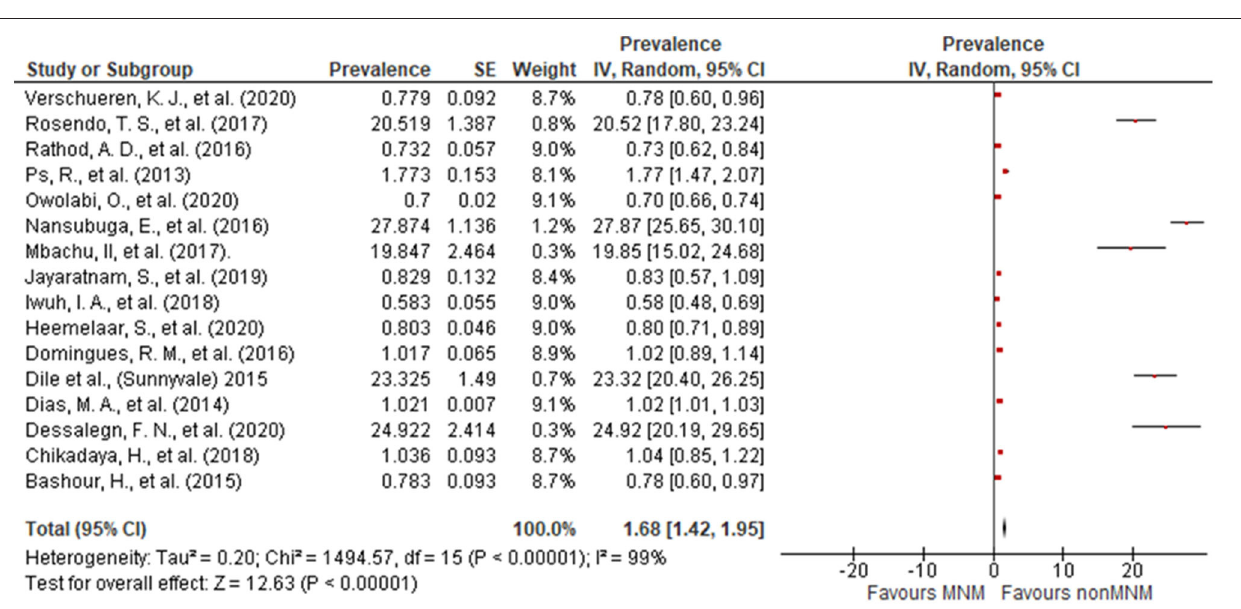
FIGURE 5 | Forest plot showing the association of history of coexisting medical conditions, vaginal delivery, and gestational period with severe maternal morbidity.